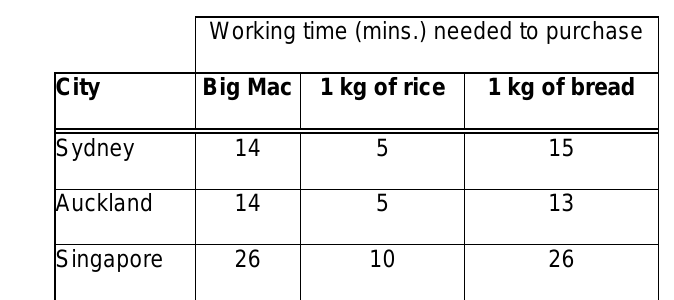
Table 7: Working time required to buy typical food items